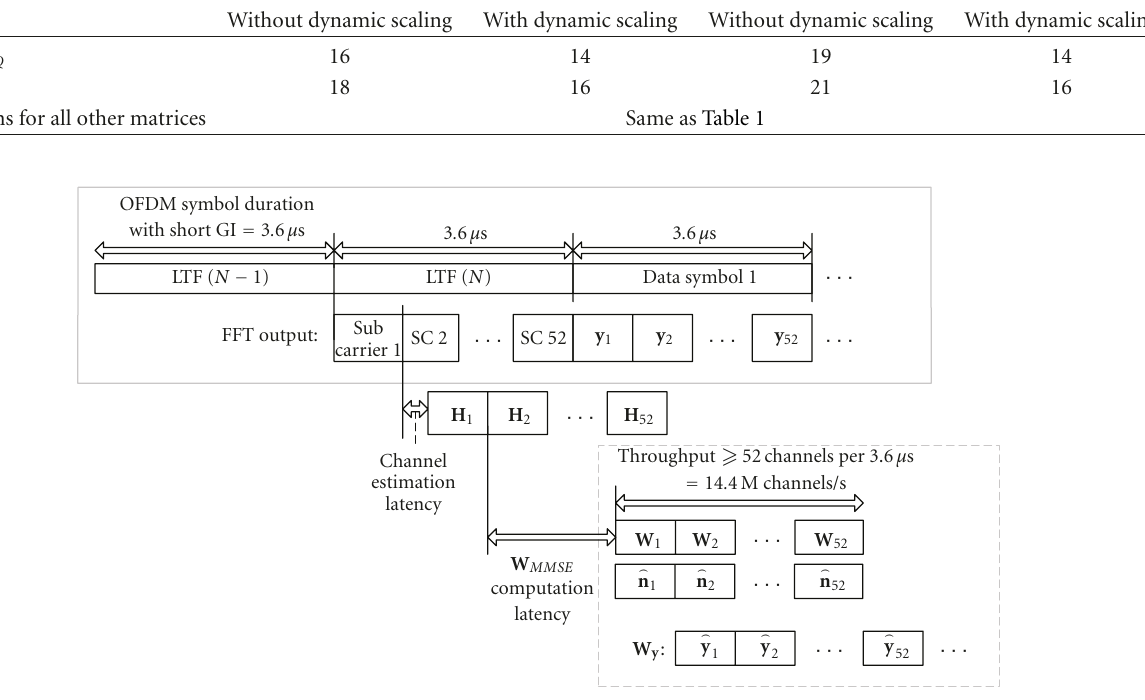
Figure 6: MIMO detection interface